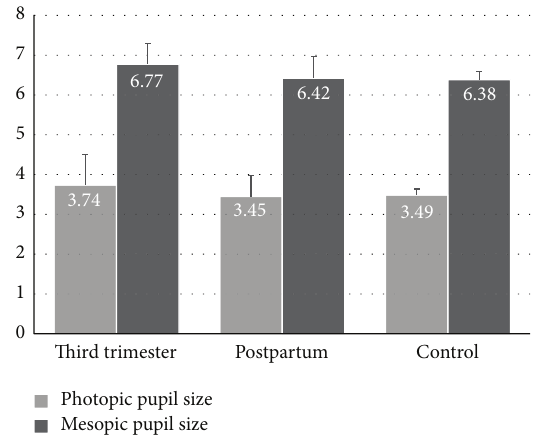
Figure 1: Bar graphics showing comparison of photopic and mes- opic pupil sizes of pregnant women at the third trimester and at the second postpartum month to nonpregnant control group of women. Error bars show + standard deviations (SD).